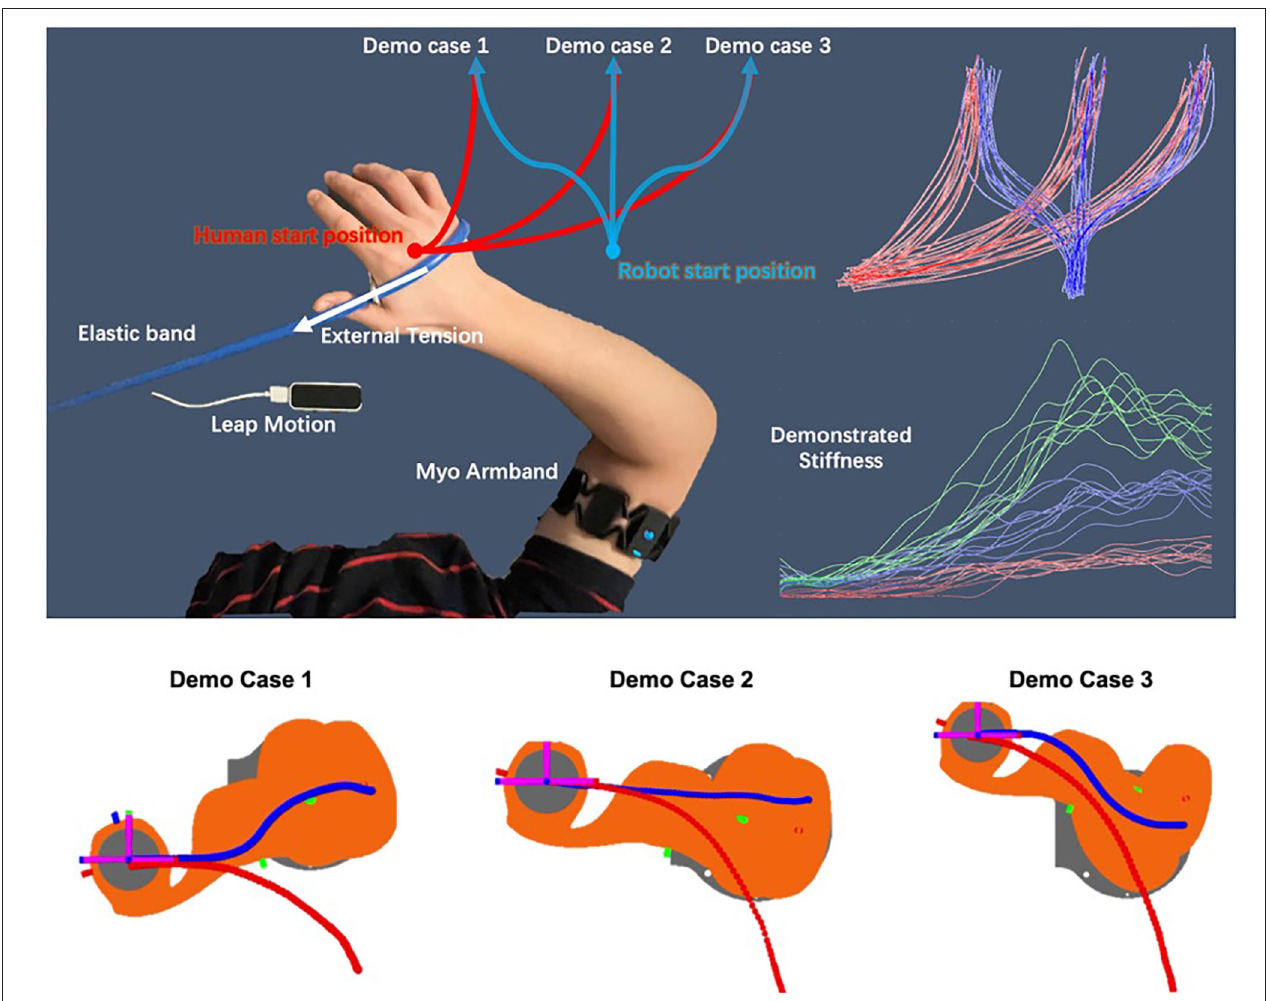
FIGURE 8 | Schematic plot of the hand-over task and the demonstrations. A virtual teleoperation is conducted for the robot side demonstrations in